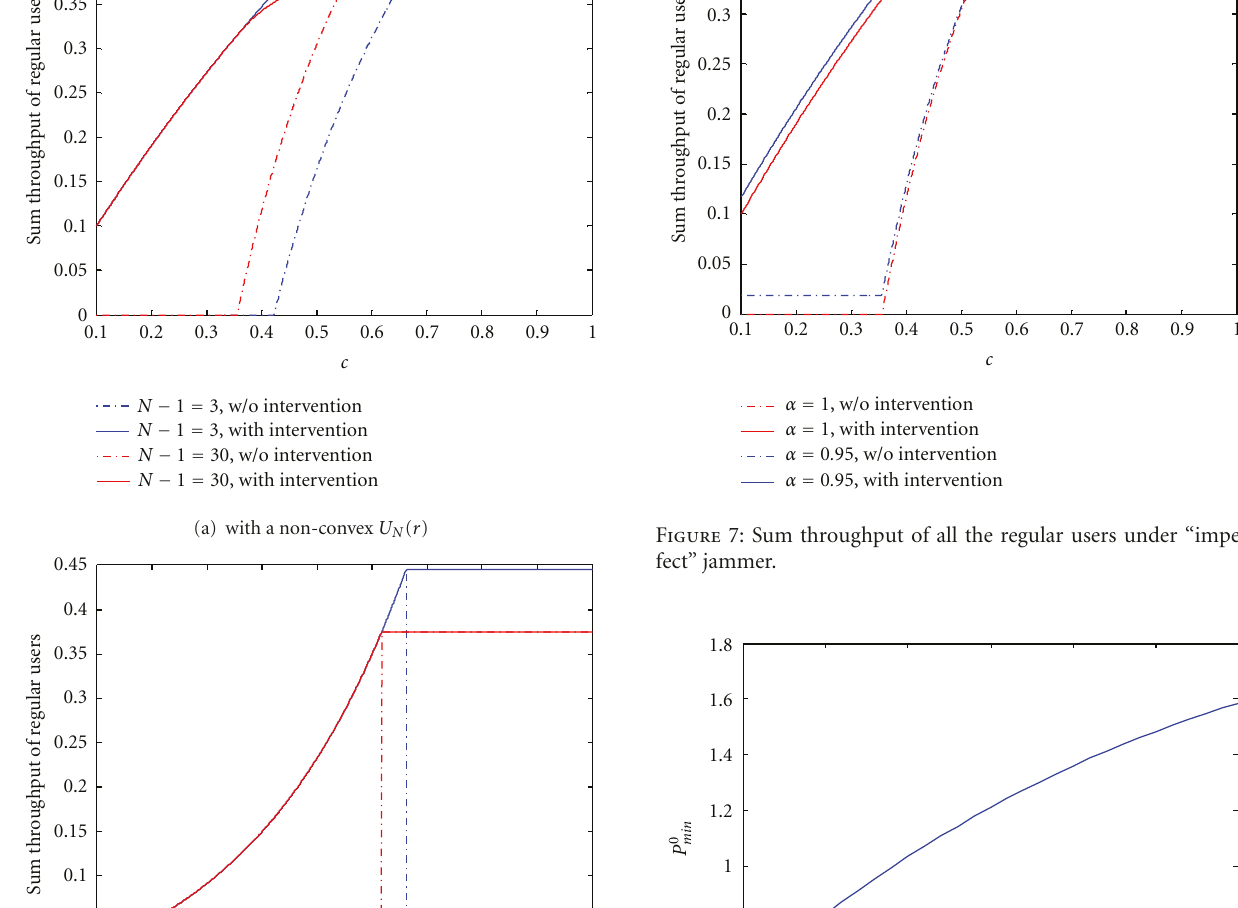
to have optimal interven-